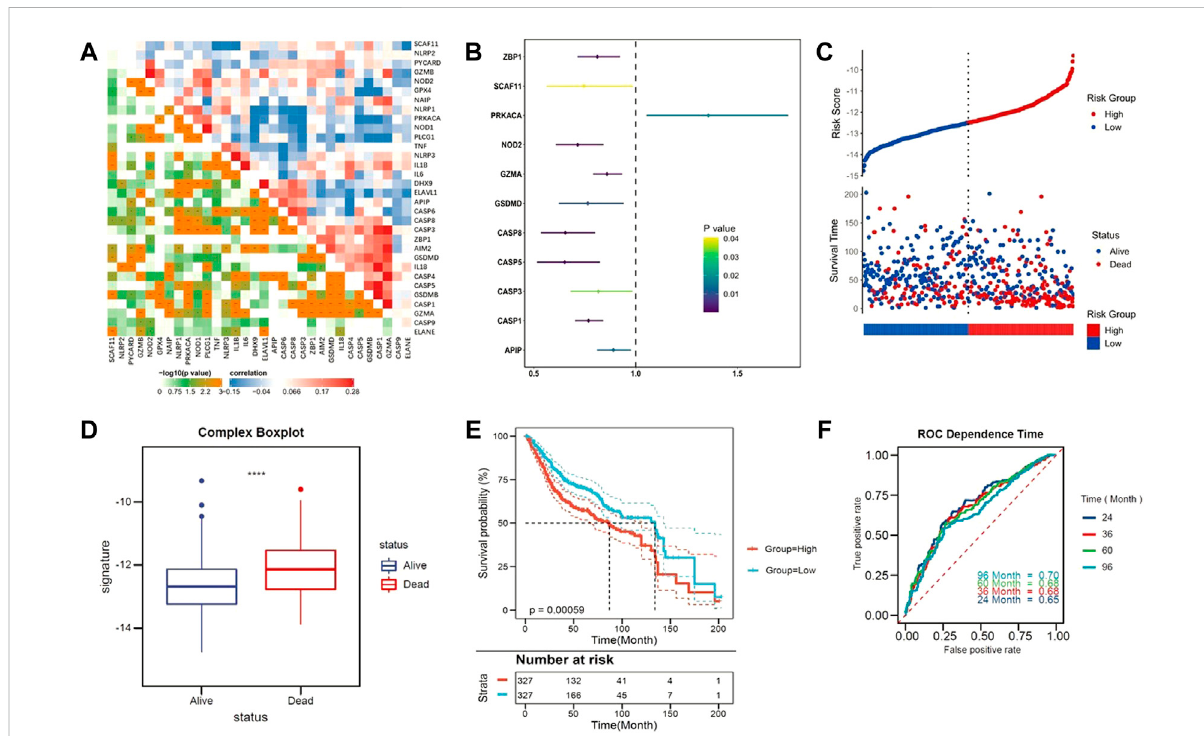
FIGURE 1 Identify the pyroptosis-related genes. (A) The correlation heatmap containing the candidate pyroptosis-related genes. (Red: positive correlation; Blue: negative correlation. The strength of the relevance was represented by the depth of the color). (B) Univariate cox regression analysis of OS for each pyroptosis-related genes. (C) Patients with low-risk scores had a survival advantage over patients with high-risk scores. (D) PyroptosisssGSEAscoresweresigni fi cantlyelevatedinpatientswhodiedduringfollowup. (E) Kaplan – MeiercurvesfortheOSofpatientsinthe high- and low-risk groups. (F) ROC curves indicated the predictive ef fi ciency of the risk